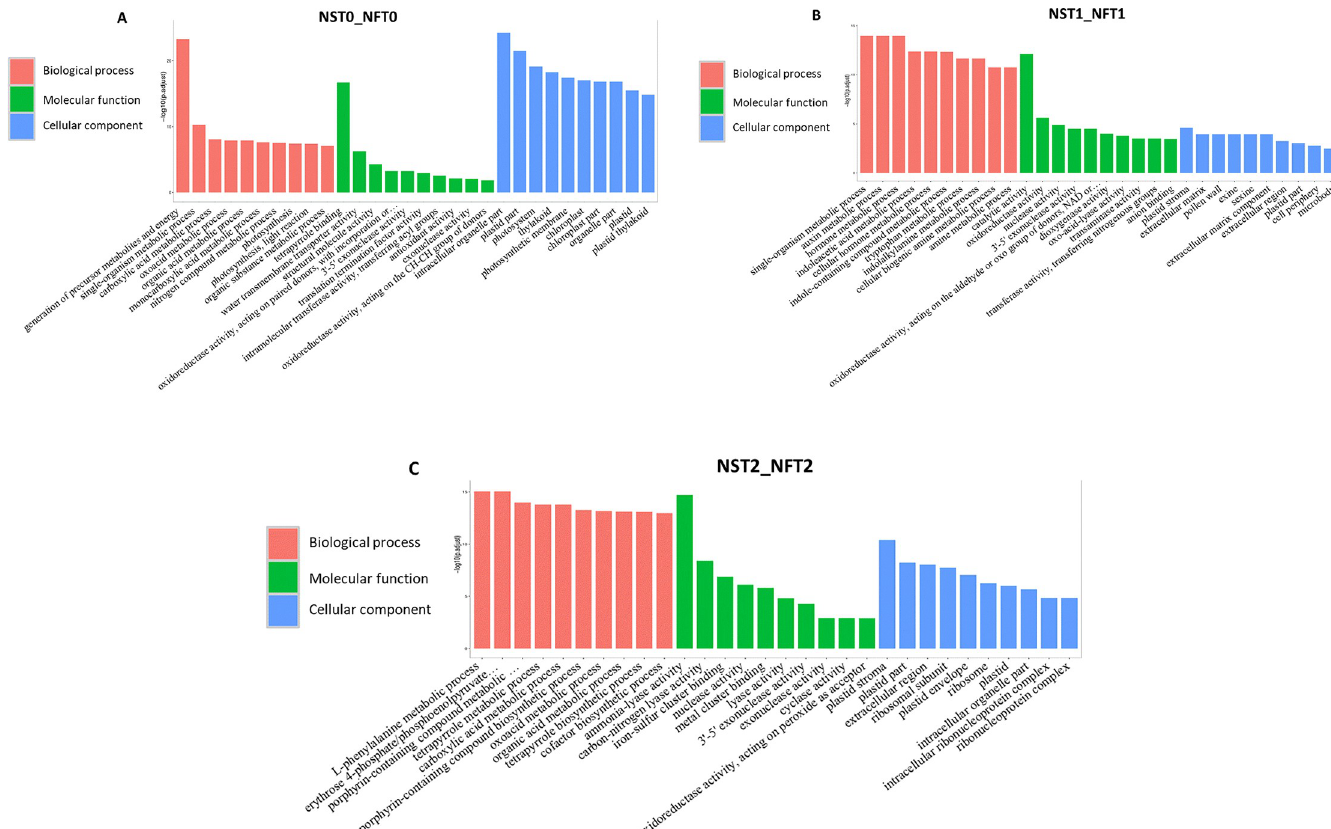
Fig 3. GO enrichment analysis of DAPs between two varieties under cold stress for 12 h (B) and 24 h (C), and control treatment (A).